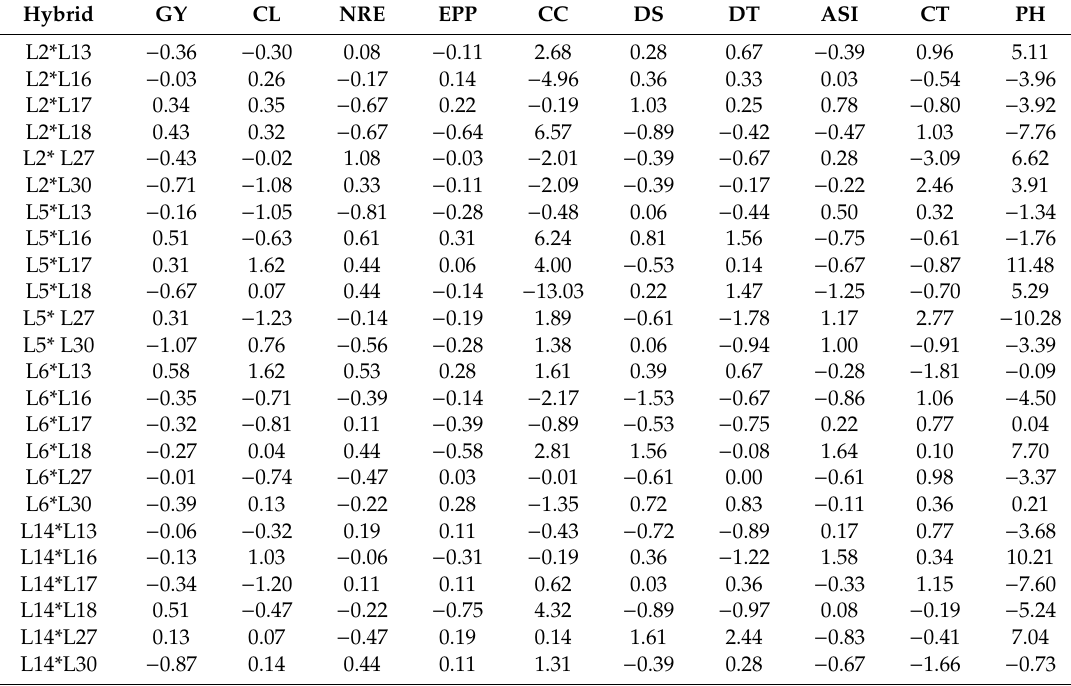
Table 9. Specific combining ability e ff ects for yield, yield components and other morpho-agronomic traits under optimum conditions.